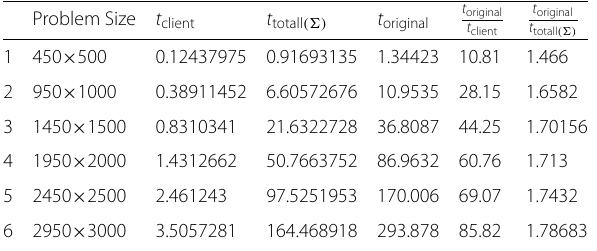
Table 4 Ax ≡ b mod 251 with